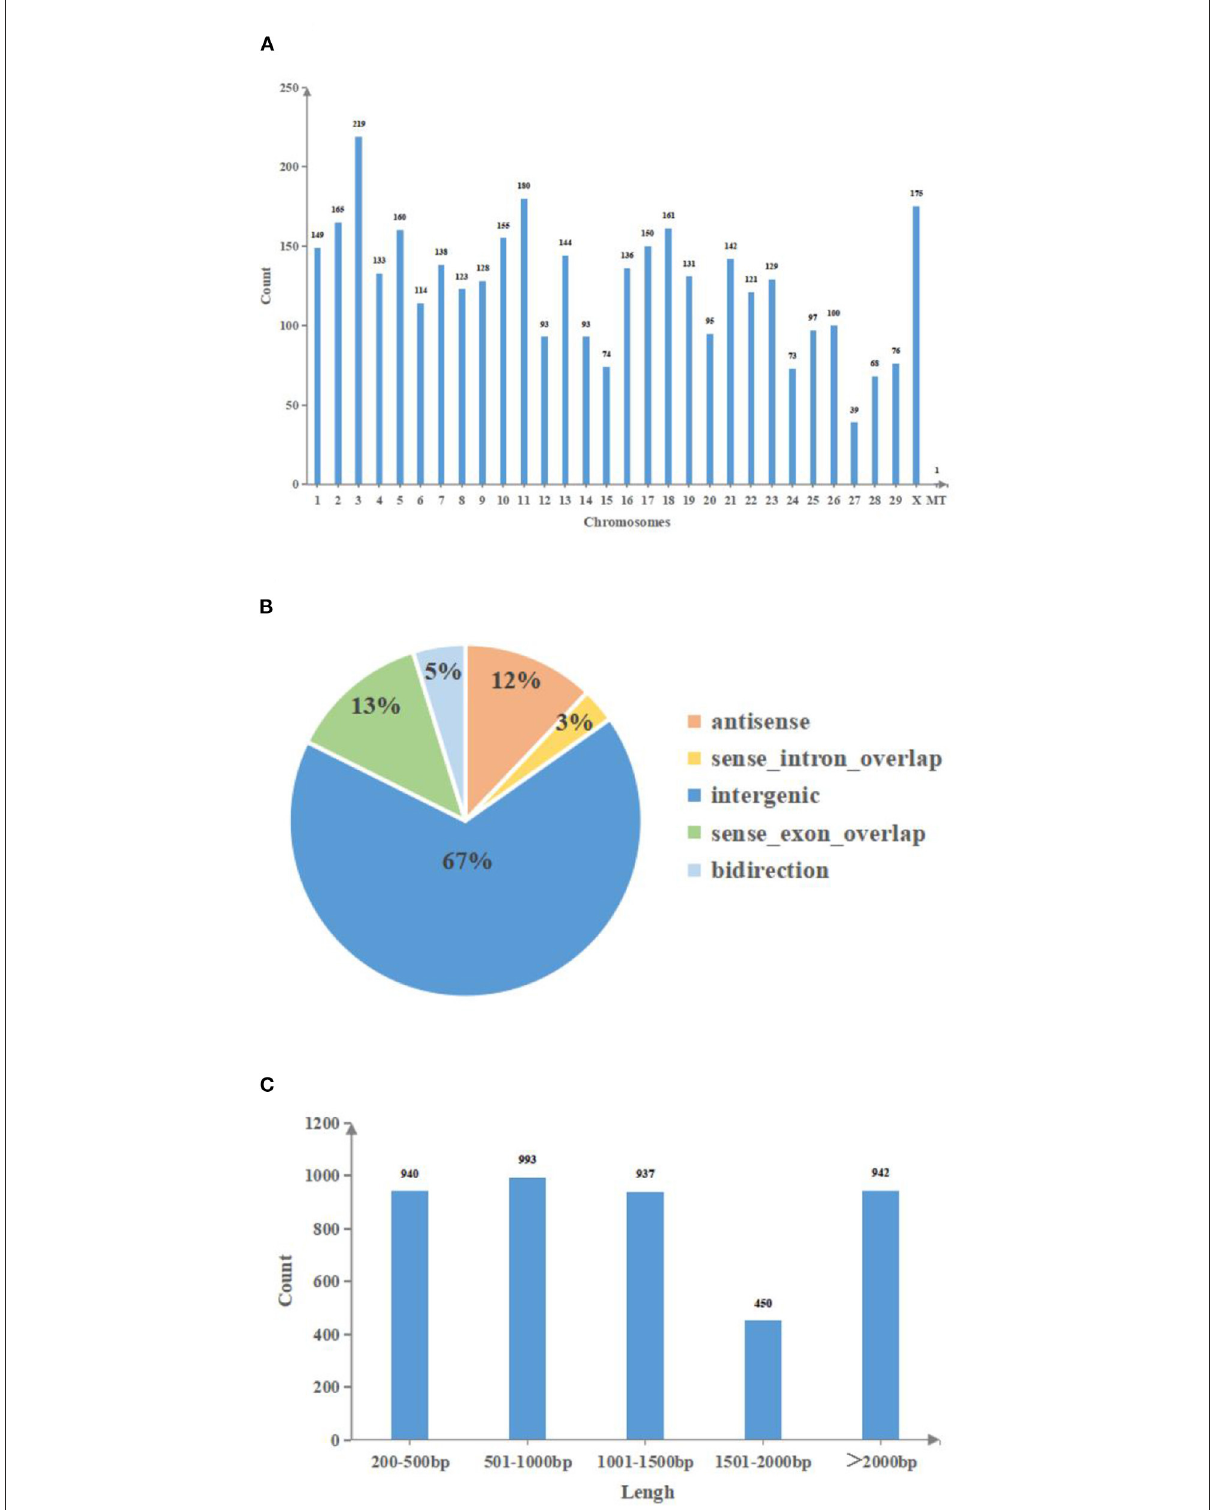
FIGURE1 The features of lncRNAs in bovine follicular GCs. (A) : Chromosomes distribution of lncRNAs. (B) : Genomes distribution of lncRNAs. (C) : Length distribution of lncRNAs. MT, mitochondria; Count, Number of lncRNA transcripts; Chromosomes, Chromosome number; Antisense, lncRNA that overlaps with the antisense chain of coding genes; Sense intron overlap, lncRNA locates in the intronic region of coding genes; Intergenic, lncRNA locates in the intergenic region of coding genes; Sense exon overlap, lncRNA that overlaps with the exon region of coding genes; Bidirection, lncRNA locates in the 1kb upstream region of coding genes, the transcription direction is opposite to coding genes; Lengh, The base number of